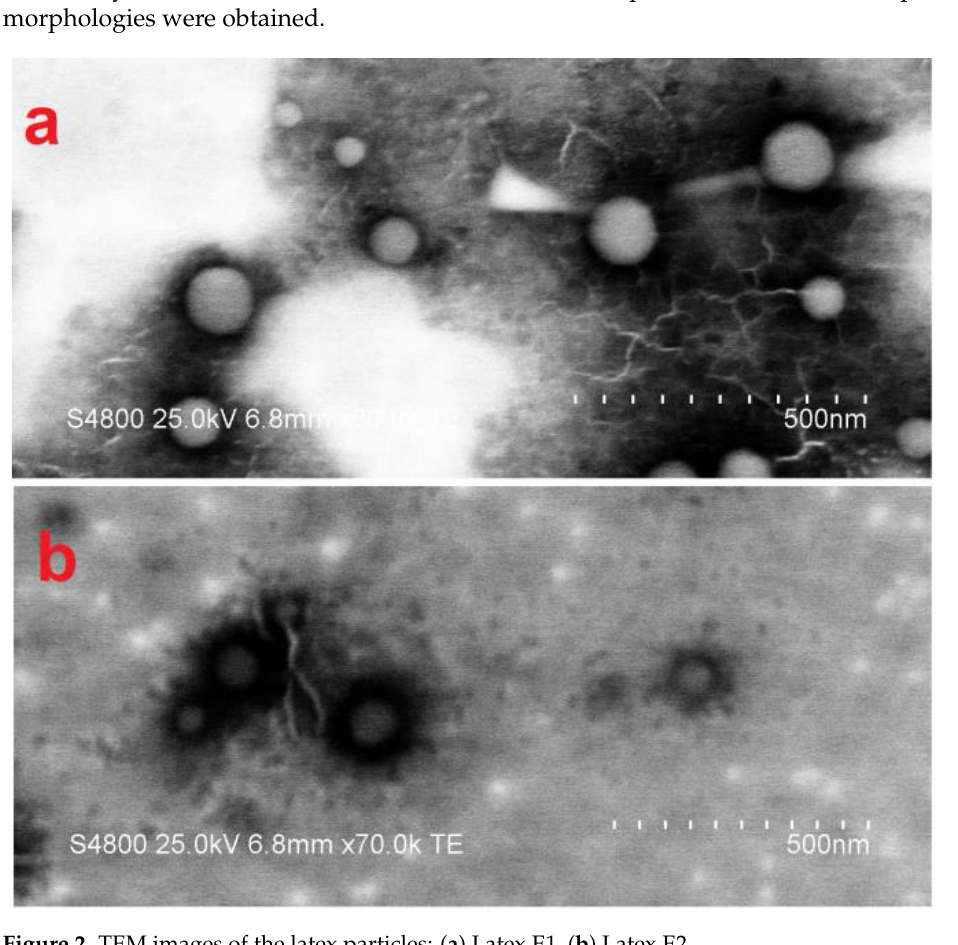
Figure 3. ATR — FTIR spectra of the synthesized latexes (E1 and E2) and pure monomers.